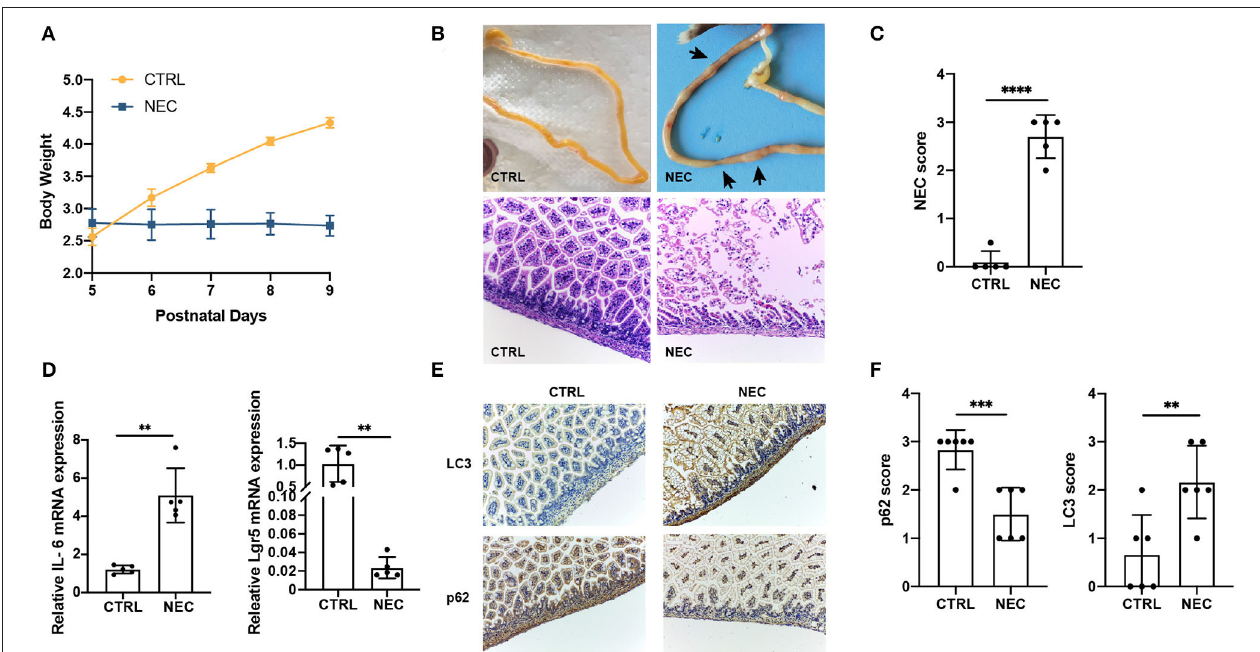
FIGURE 1 | Validation of the necrotizing enterocolitis (NEC) model and upregulated the autophagy level. (A) Changes in the bodyweight of mice in NEC and CTRL groups. (B) The representative images of morphology and H and E micrographs of the distal ileum of NEC and CTRL mice. (C) The NEC scores in NEC and CTRL groups. (D) The relative interleukin 6 (IL-6) and Leucine-rich repeat-containing G-protein coupled receptor 5 (Lgr5) messenger RNA (mRNA) expression in NEC and CTRL groups. (E) Representative immunohistochemistry (IHC) staining of LC3 and p62 in ileum tissues of NEC and CTRL mice. (F) Immunohistochemistry scores of LC3 and p62 in NEC and CTRL groups. Data are expressed as mean ± SD. ** p < 0.01; *** p < 0.001; **** p <